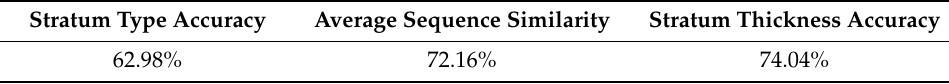
Table 9. Statistical results of the geostratigraphic series model simulations.